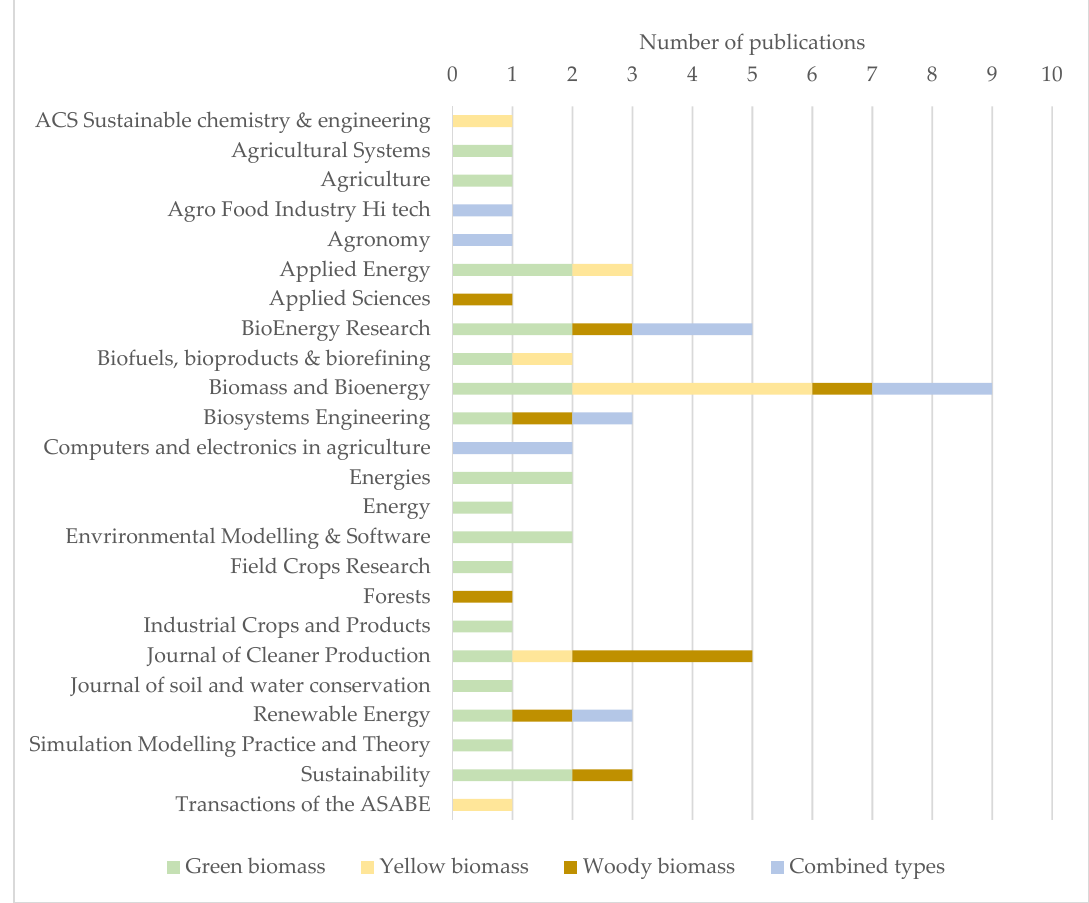
Figure 3. Number of papers extracted by each journal.